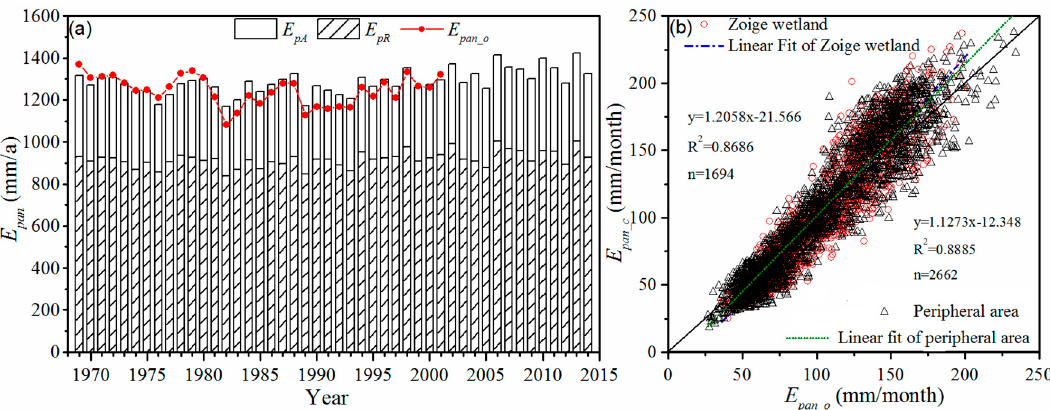
Figure 4. Comparison between the observed pan evaporation ( E pan_o ) and the PenPan model-calculated pan evaporation ( E pan_c ): ( a ) variations of the annual E pan_o and E pan_c (including the E pA and E pR ) in the Zoige wetland, and ( b ) linear fit regression of monthly pan evaporation in the Zoige wetland and its peripheral area.